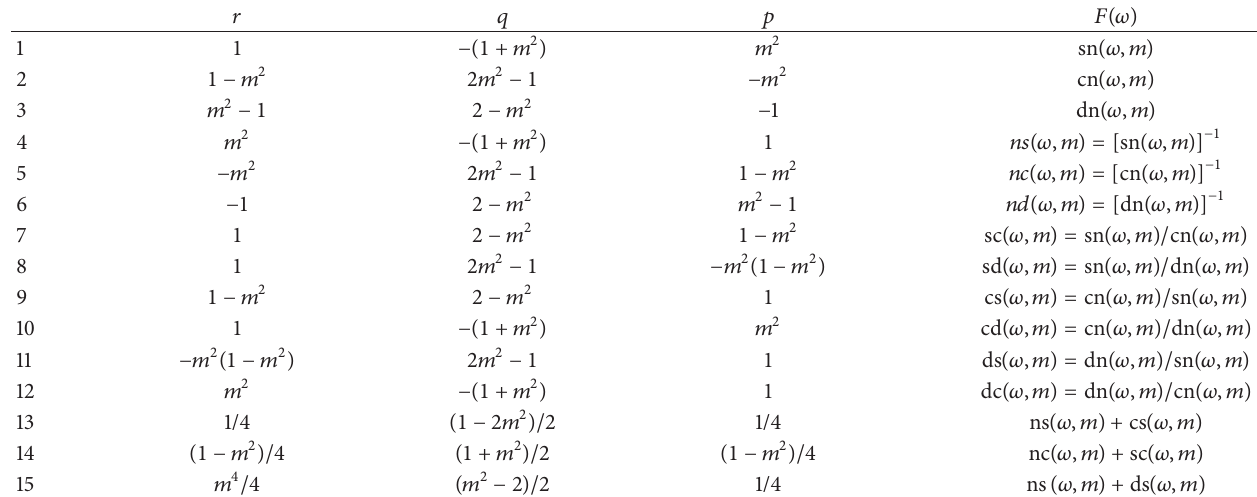
Table 1: Exact solutions of (𝑑𝑓(𝑤)/𝑑𝑤) 2 = 𝑟 + 𝑞𝐹 2 + 𝑝𝐹 4 (𝜔)(𝜔)